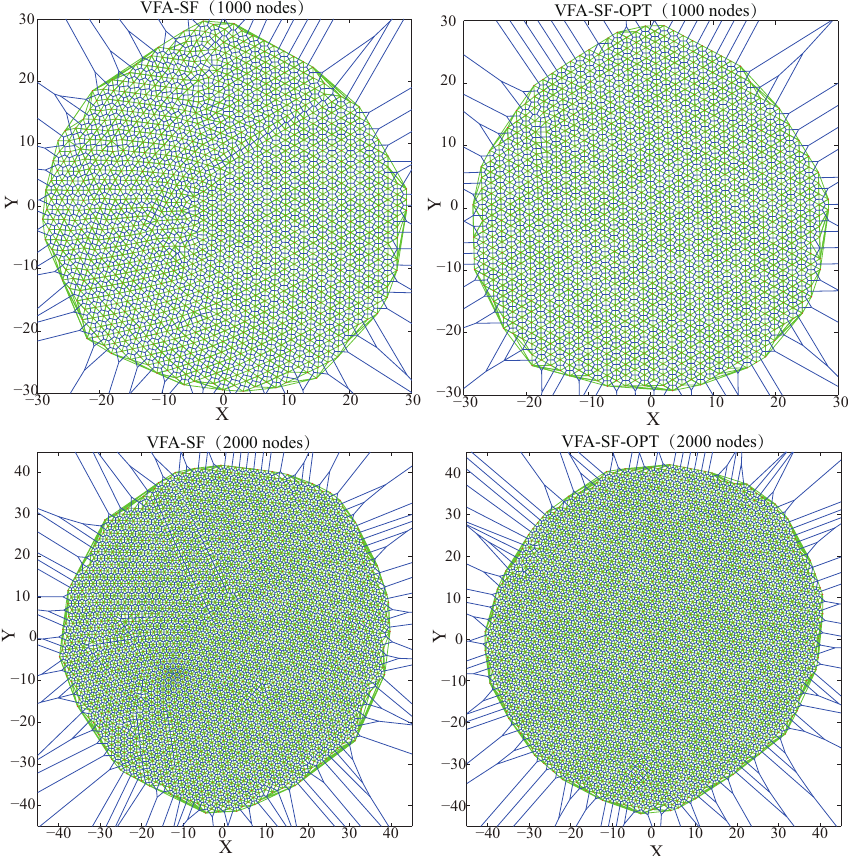
Figure 10. The final network distributions for 1000 sensor nodes ( top ) and 2000 nodes ( bottom ) from VFA-SF ( left ) and VFA-SF-OPT ( right ),